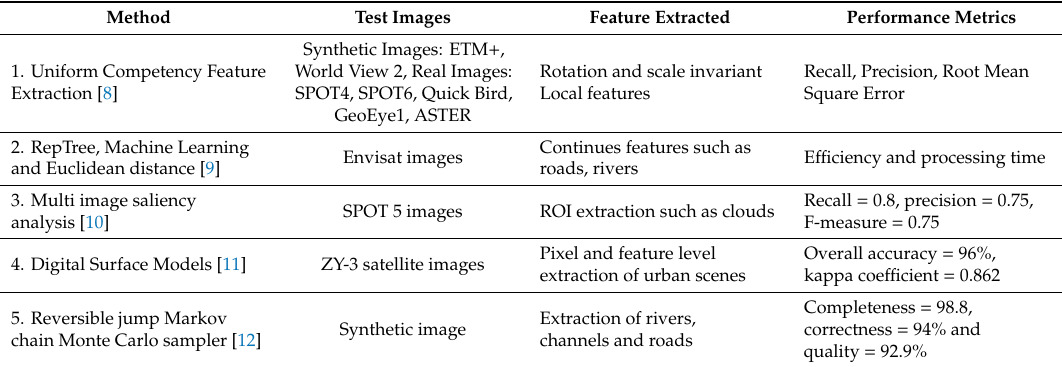
Table 2. Feature extraction and their performance